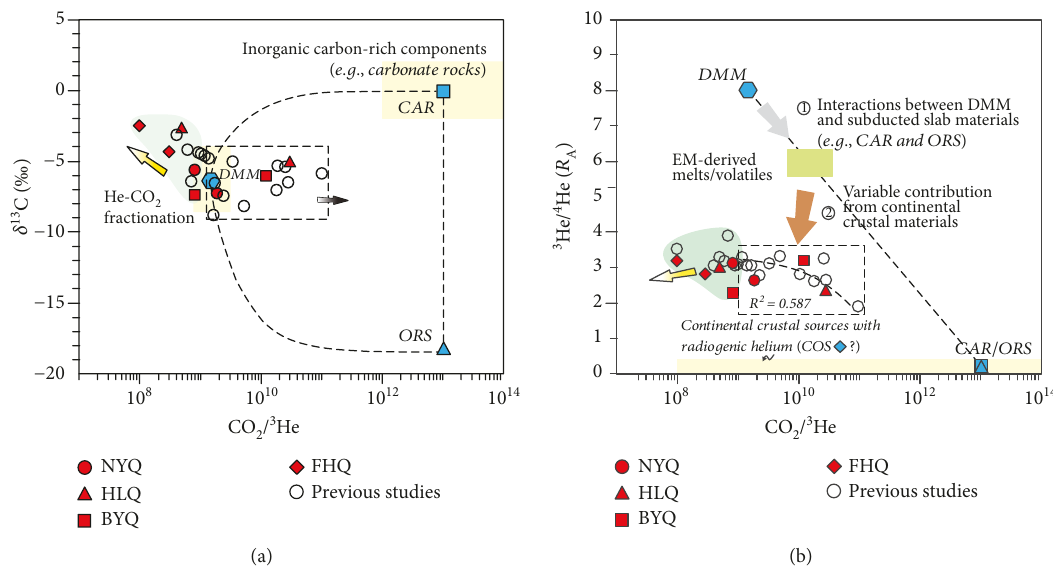
Figure 6: (a) δ 13 C ( ‰ ) versus CO / 3 He ratios for cold spring gases from WMVF. The yellow arrow denotes the e ff ects of He-CO 2 2 fractionation on the samples outside the mixing envelope. (b) 3 He/ 4 He (R ) versus CO / 3 He ratios for cold spring gases from WMVF. A 2 Abbreviations and reference values for end members are as follows: CAR: carbonate rocks ( δ 13 C = 0 ± 2 ‰ , [53]); ORS: organic sediments ( δ 13 C = − 18 5 ‰ , [35]). The 3 He/ 4 He ( R A ) ratios of CAR and ORS end members are assumed to be 0 02 R A [66] and the CO / 3 He values 2 / 3 He ratios of DMM are ranging from 7 5 × 10 8 to 3 × 10 9 , with an average of 1 5 × 10 9 [46]. The ranging from 10 12 to 10 14 [62]. The CO 2 continental crustal source has a wide range of CO / 3 He ratios based on [62]. Data source and symbols are as in Figure 5. 2